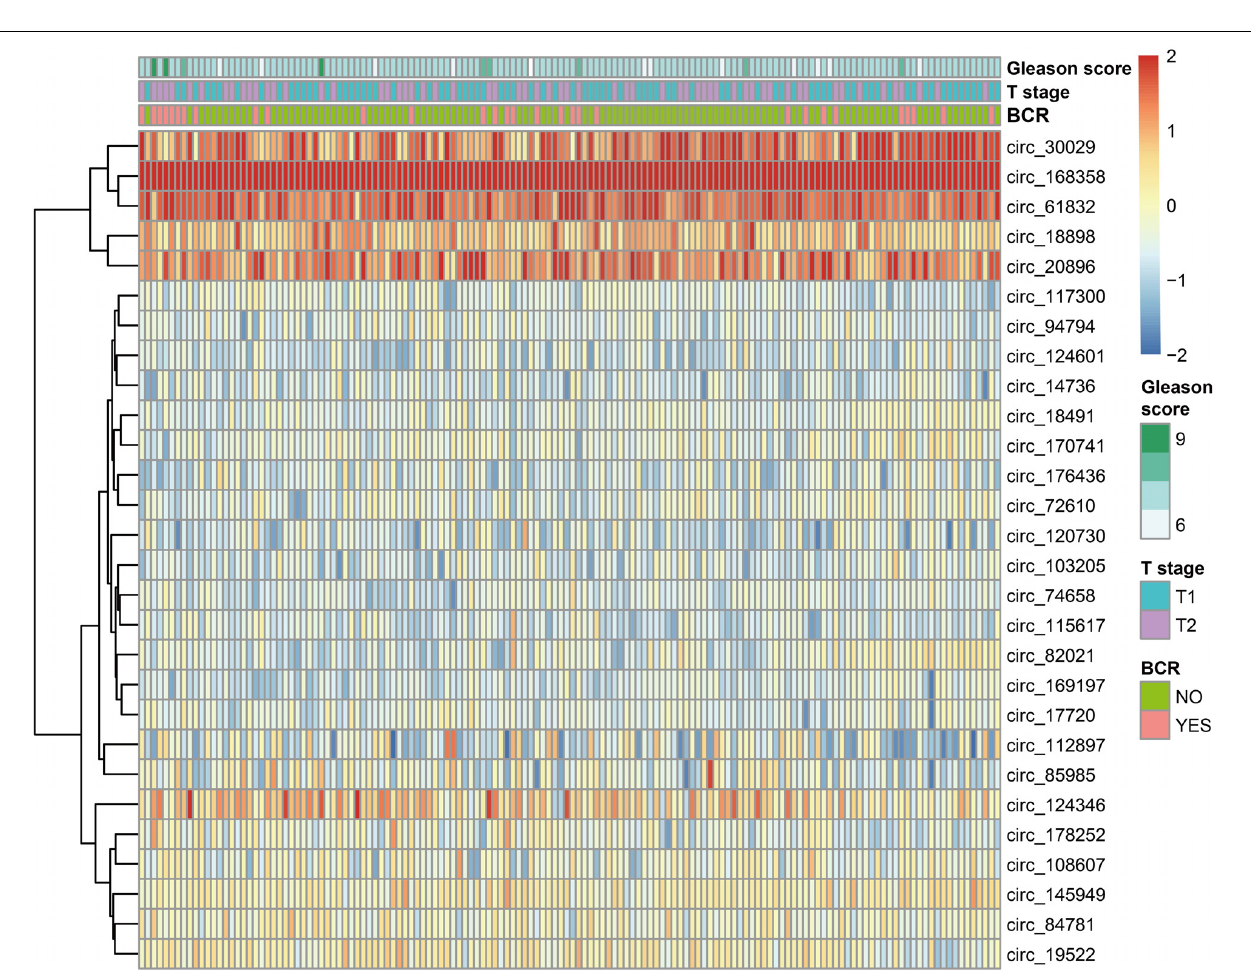
level of circ_115617) + (0.0027 ∗ expression level of circ_14736) + (0.0906 ∗ expression level of